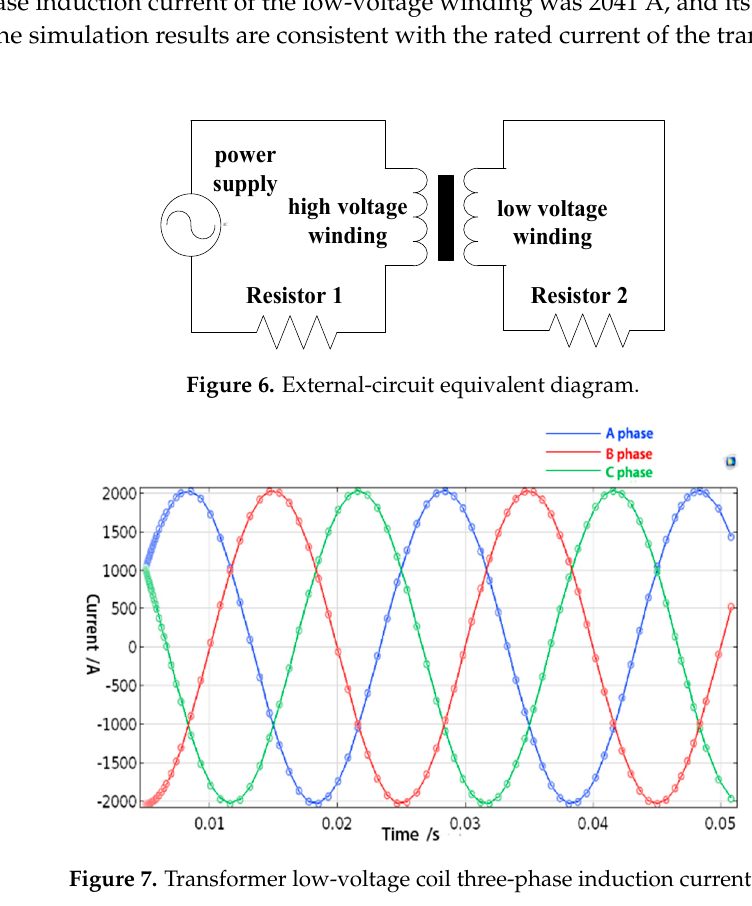
Figure 7. Transformer low-voltage coil three-phase induction current.